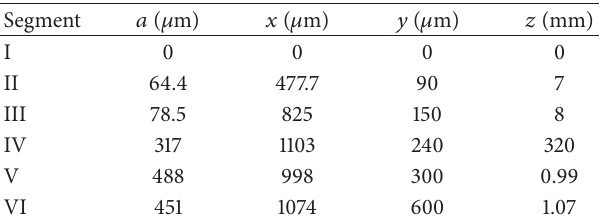
Table 1: Dimensional specifications of different areas of copper substrate presented in Figure